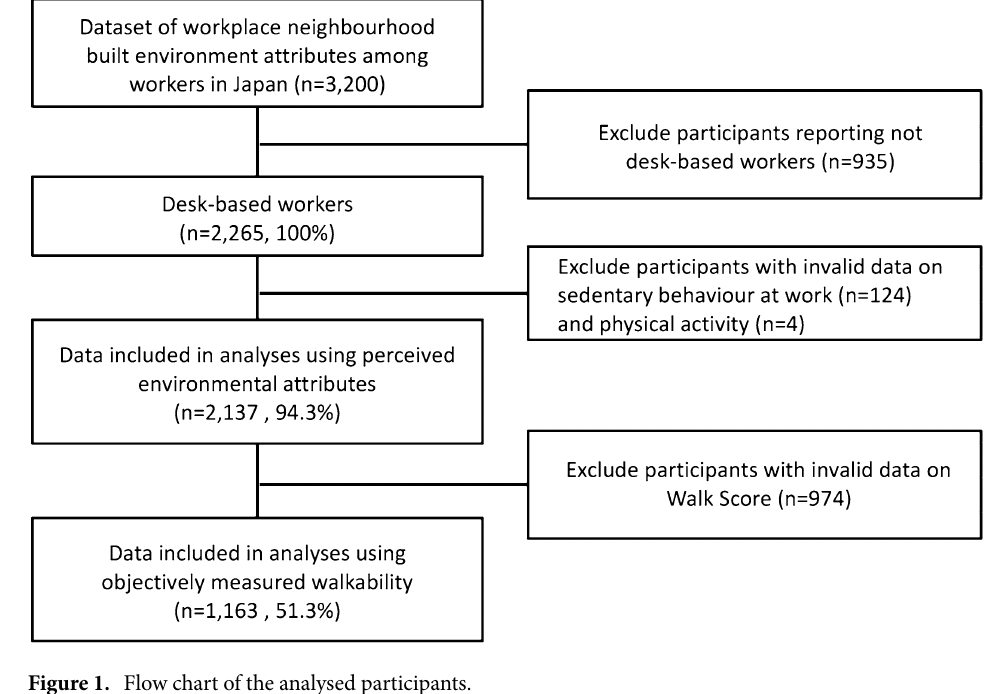
Figure 1. Flow chart of the analysed